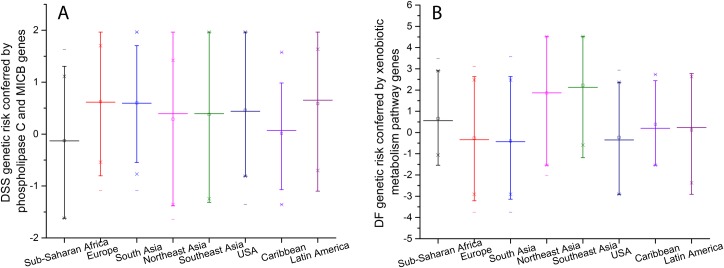
Genetic risk for the various worldwide regions by considering an additive model of protective and causative haplotypes/SNPs for DSS (A) and DF (B). Median (middle line), mean (little square), 95% confidence interval (whiskers) and extreme values (crosses) are indicated.